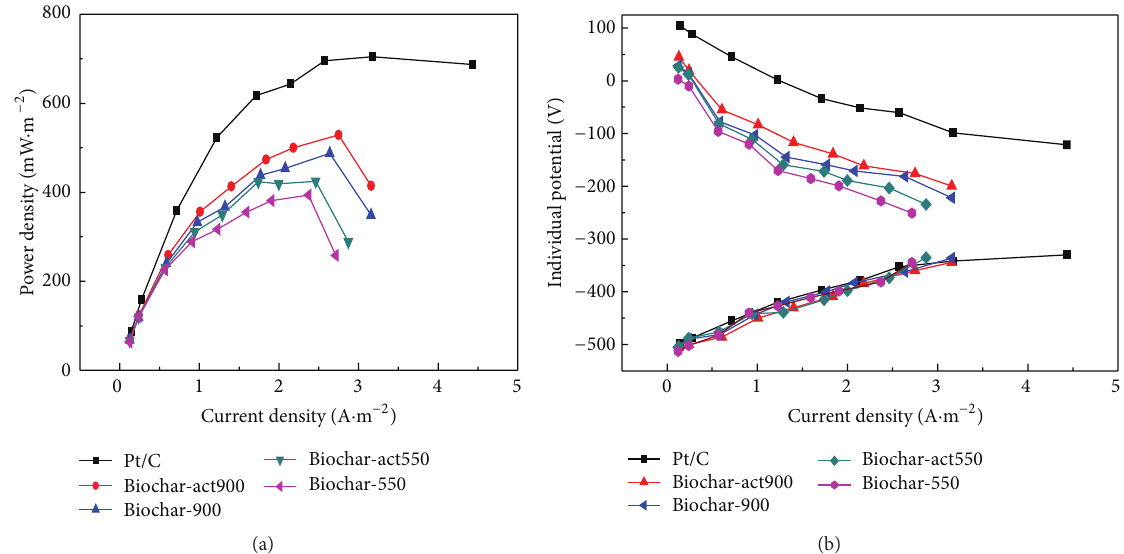
Figure 7: Performance of MFCs equipped with biochar. (a) Polarization curves of the MFCs with various cathode catalysts, (b) individual potentials versus current density